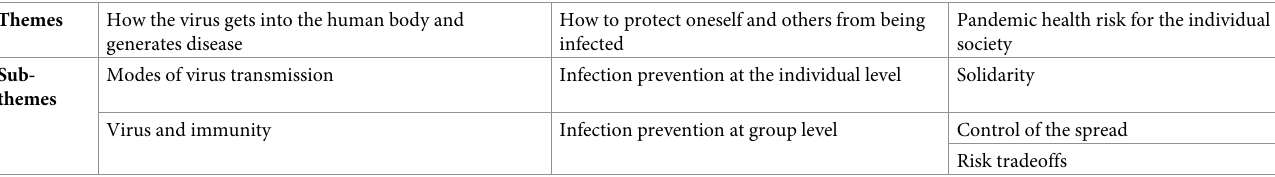
Table 2. Key topics to communicate to the public related to pandemic